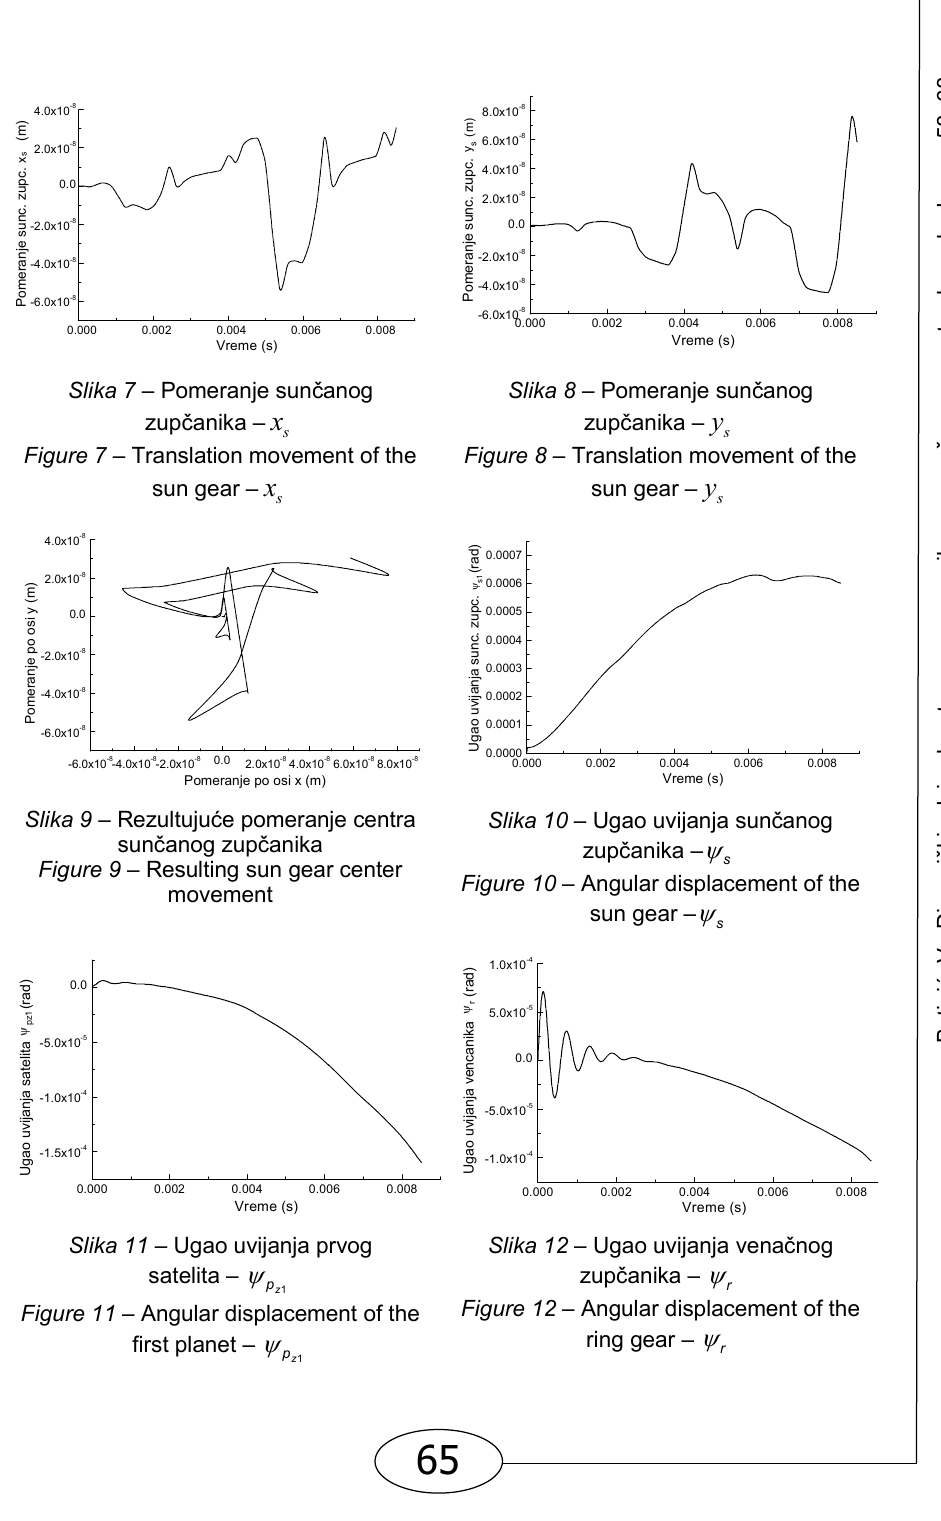
Figure 11 – Angular displacement of the first planet –